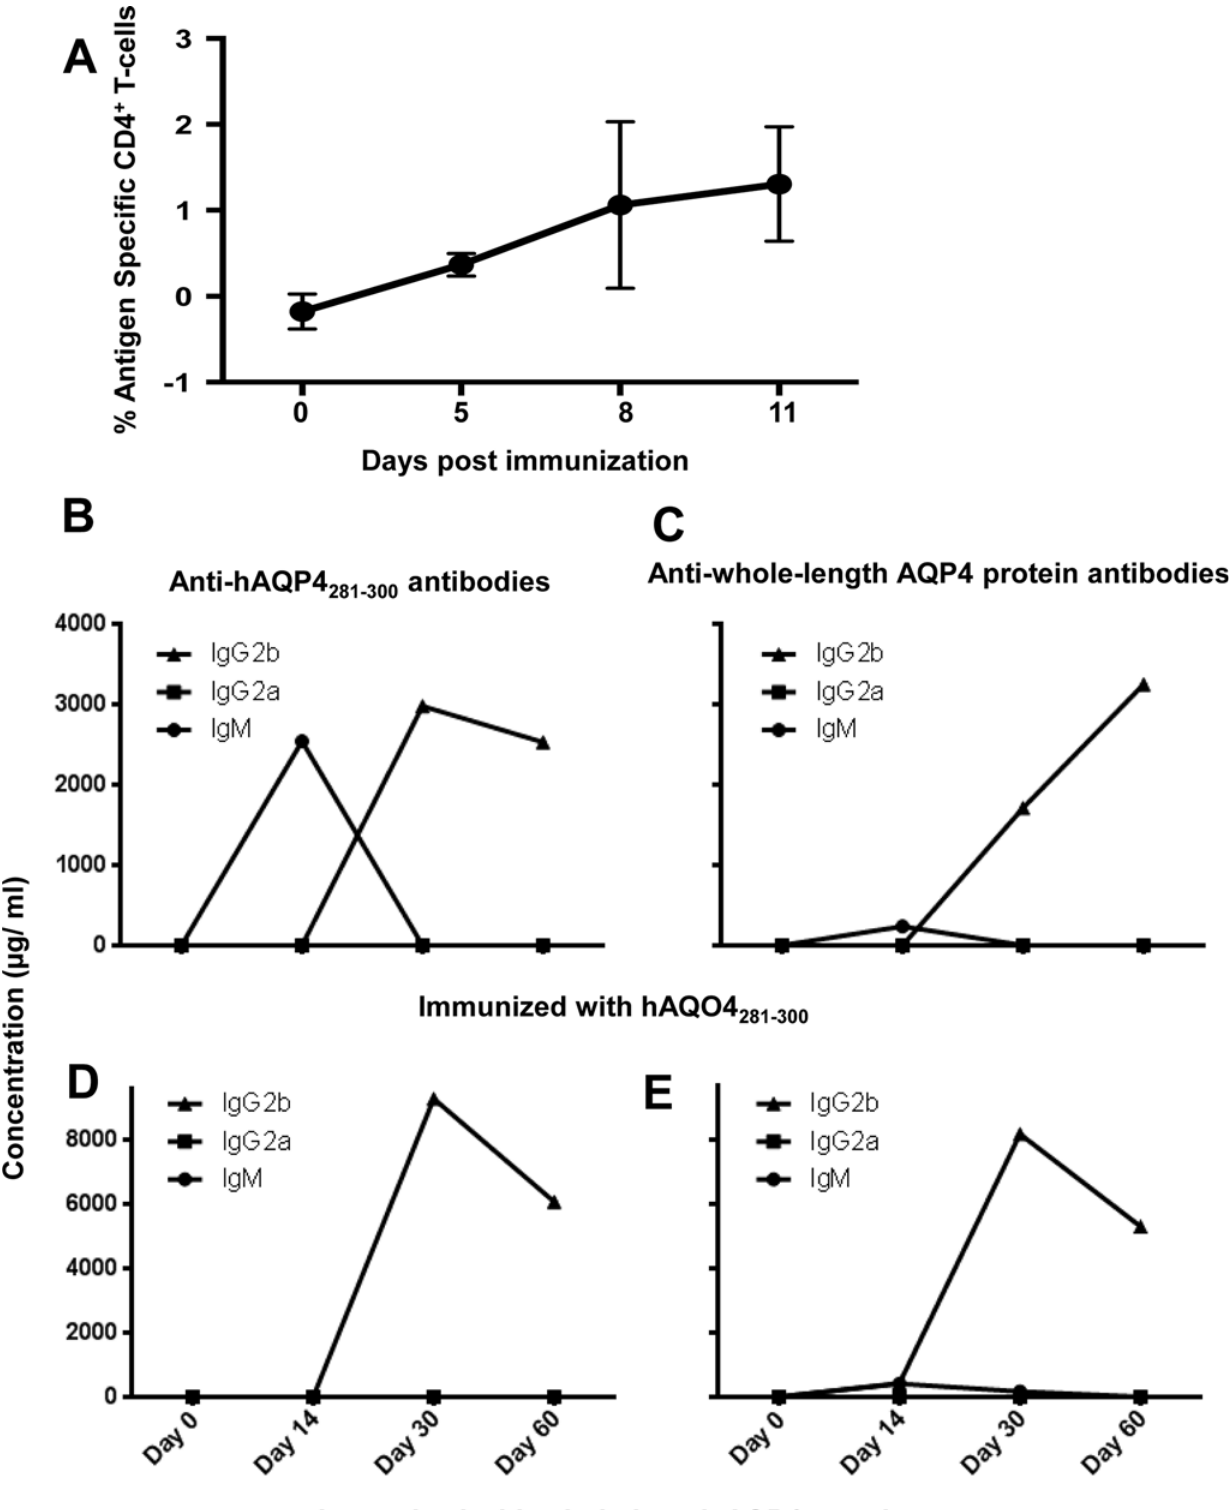
PLOS ONE | DOI:10.1371/journal.pone.0152720 April 7,